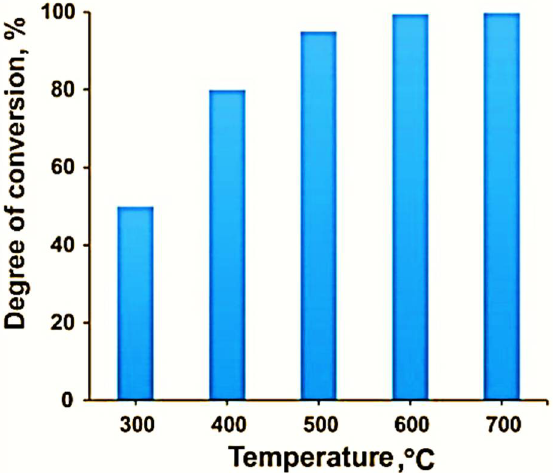
Figure 3. Dependence of the conversion degree of titanium fluorides into titanium dioxide on the pyrohydrolysis temperature.